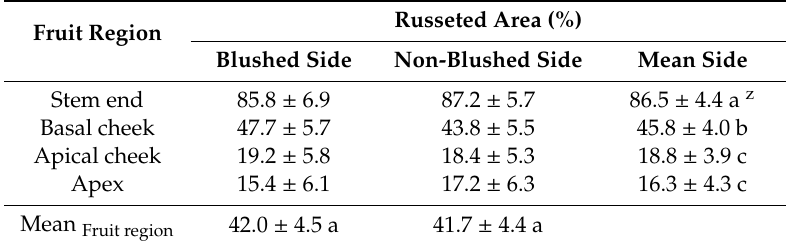
Table 1. Percent distribution of russet on ‘Apple’ mango fruit along the stem / apex axis on either the blushed or the non-blushed sides of the fruit. Percentage of russet was quantified using image analysis following photography. For the di ff erent regions of the fruit, see Figure 7.